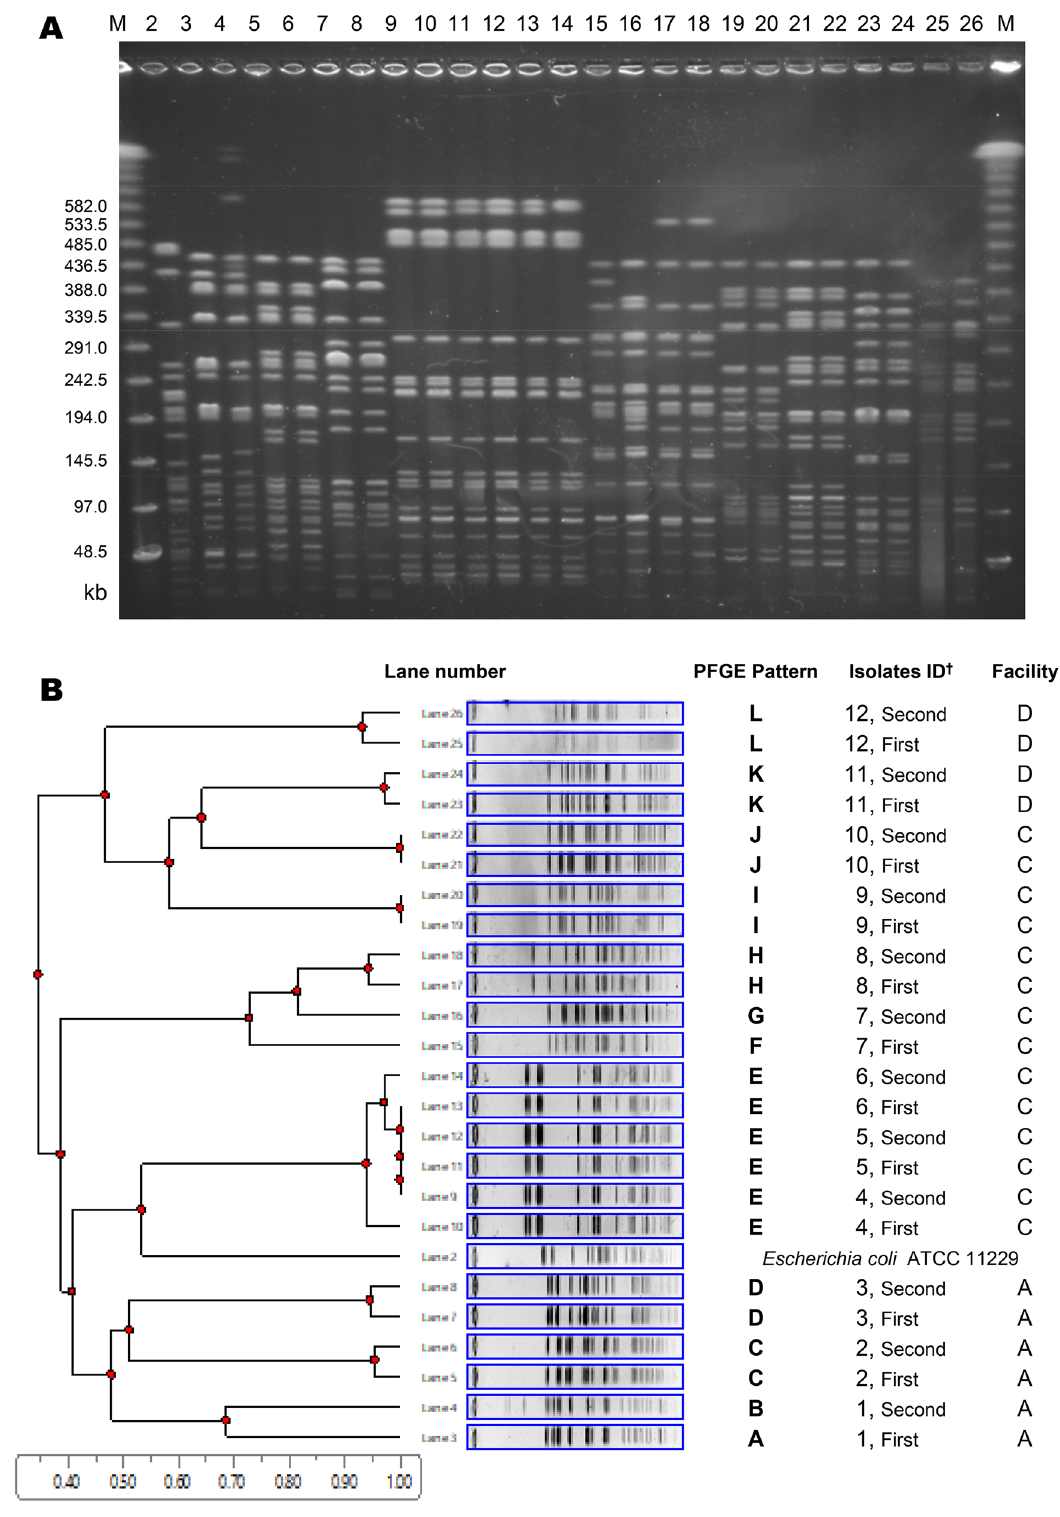
Figure 3. Pulsed-field gel electrophoresis typing. ( A ) Original pulsed-field gel electrophoresis (PFGE) profiles of E. coli strains isolated from 12 residents. Lanes 1 and 27, molecular weight marker; lane 2, E. coli ATCC 11,229; and lanes 3–26, E. coli strains isolated from 12 residents. ( B ) The dendrogram was created by UPGMA clustering method using the software CLIQSTM (Totallab Ltd), and PEGE patterns were automatically rearranged in a figure. † Resident identification number and ESBL-E carriage testing (the first or second) Note : The figure could not show the results of all the 44 strains (22 pairs) altogether because of a limit of the analytic device (thus, shows selected 24 strains